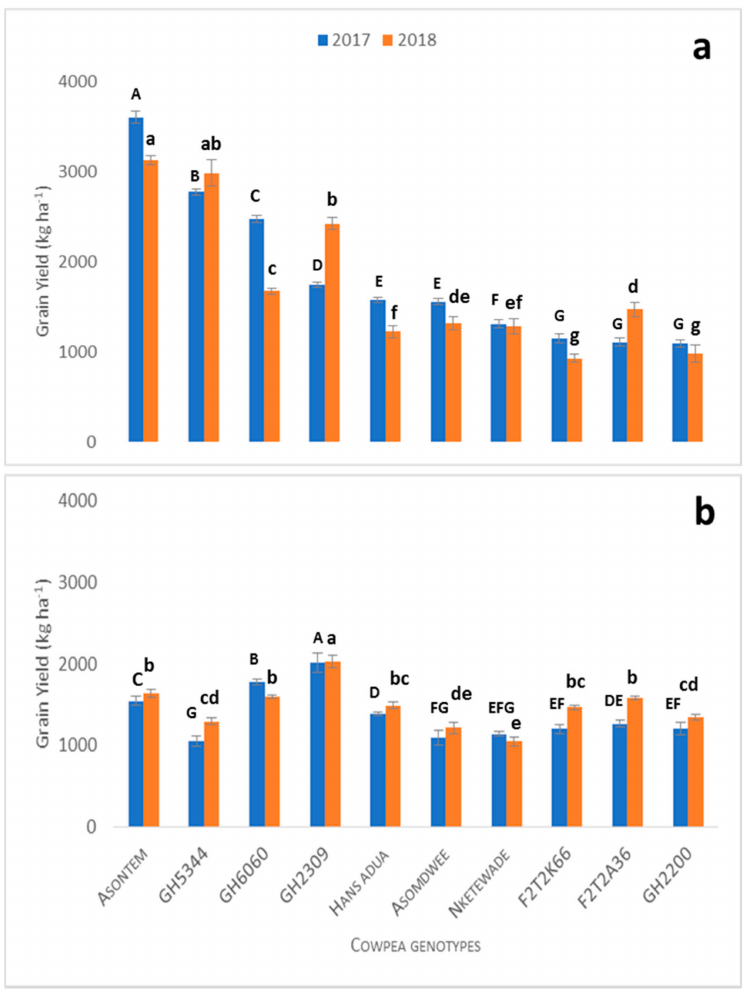
Figure 1. Grain yield of cowpea genotypes under no water stress with phosphorus treatment (60P + NWS) at maturity in 2017 and 2018 planting season ( a ) and under P stress conditions (0P + NWS) at maturity in 2017 and 2018 ( b ). Vertical bars represent ± S.E. of the mean ( n = 3). Different letters above the columns indicate statistical significance at the p < 0.05 level within the same measurement stage (capital letters compare significance levels within 2017 and small letters compare significance levels within 2018). Bars showing the same letters indicate no significant differences between genotypes at p <